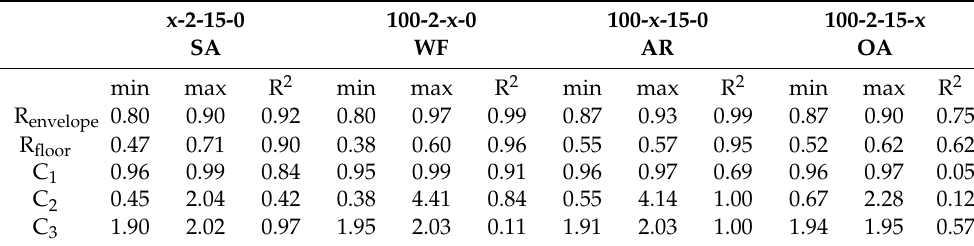
Table 9. Linear regression results of estimated/calculated parameters for heavy-structured buildings.